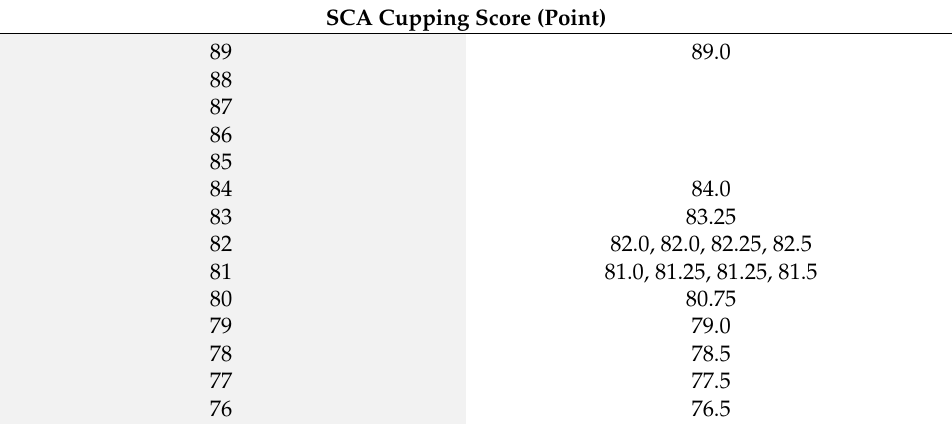
Table 1. Sixteen green coffee beans from Guatemala were evaluated using the SCA cupping